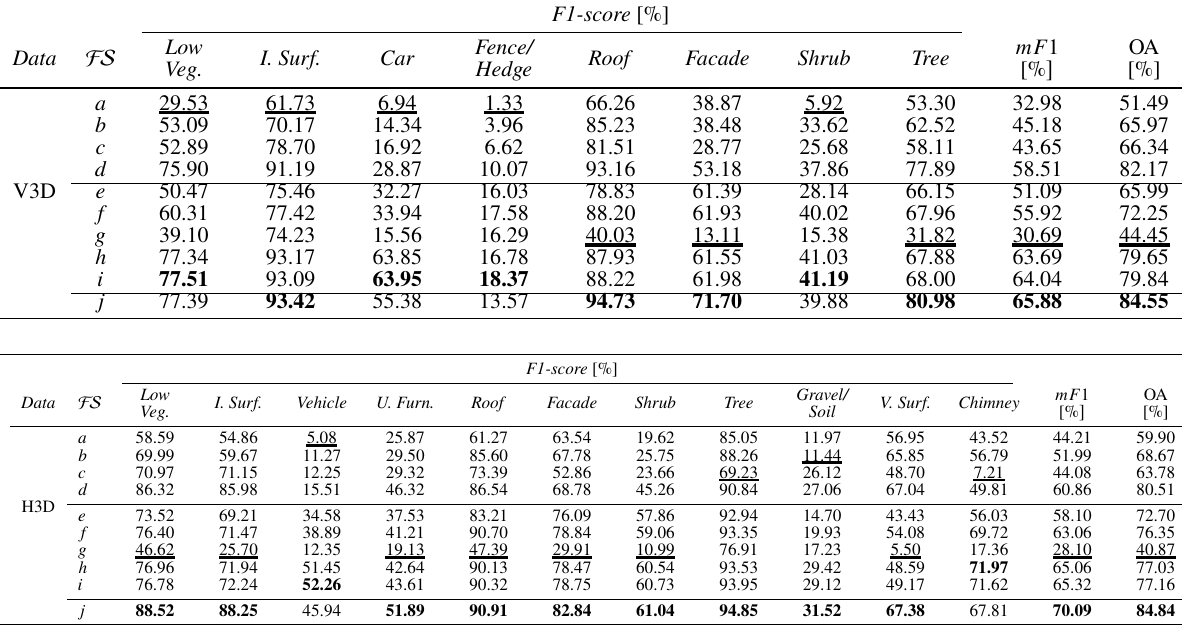
Table 2. Semantic segmentation results on the test site of V3D ( top ) and H3D ( bottom ) achieved with RF models deploying various feature vector compositions FS (cf. Table 1). The performance metrics are weighted by the covered class area. Best performing metrics are marked in bold ; worst are underlined